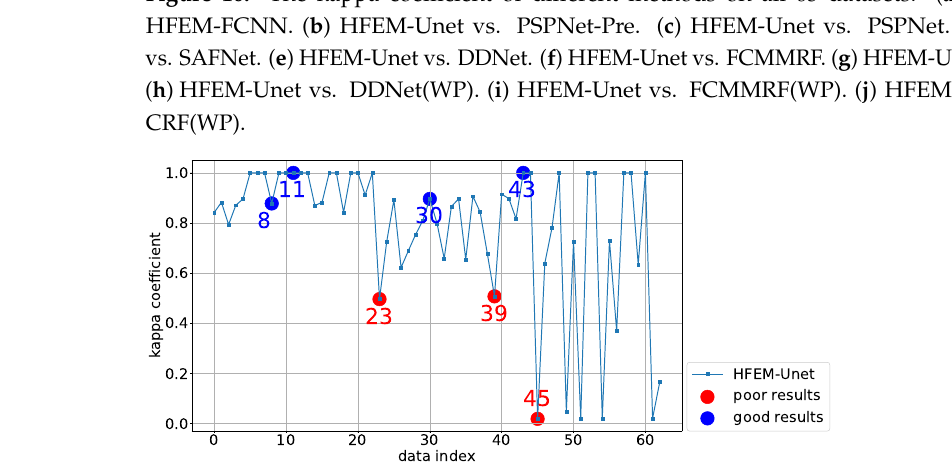
Figure 17. The indices of the selected patches for visualization. Seven patches are selected, including four patches with good results and three patches with poor results. The indices of the four patches with good results are 8, 11, 30 and 43, which are represented by blue dots. The indices of the three patches with poor results are 23, 39 and 45, which are represented by red